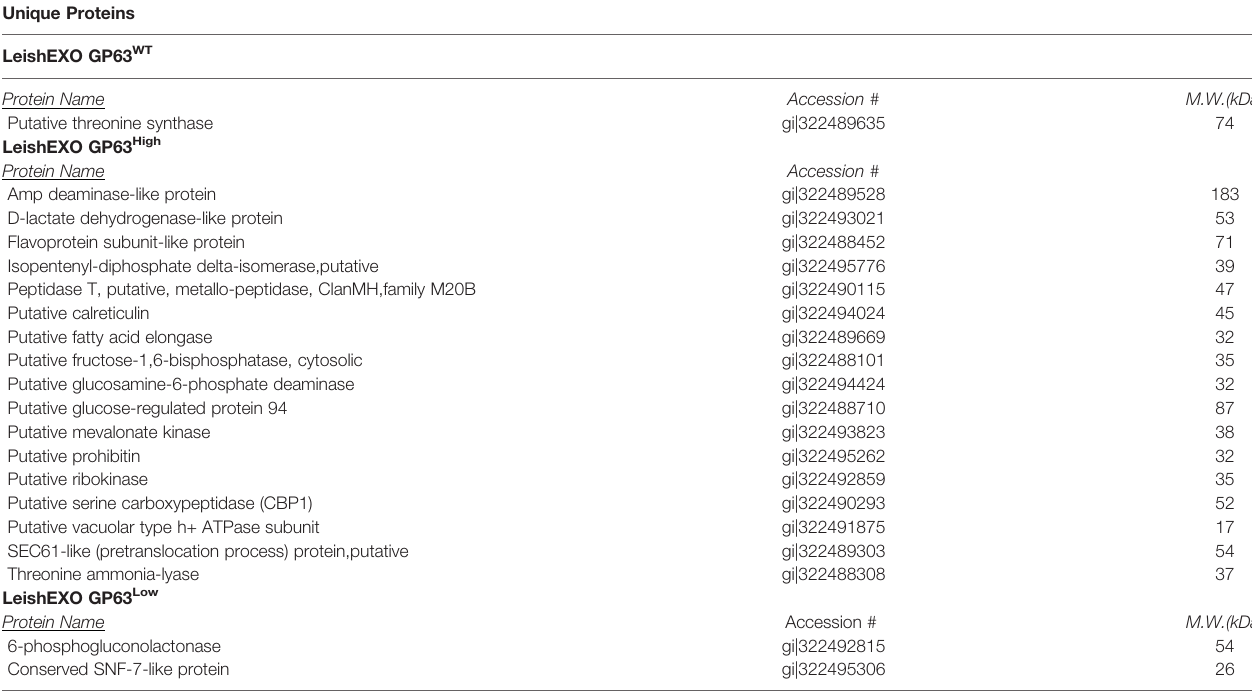
TABLE 1 | Unique proteins of Leishmania amazonensis GP63 WT , GP63 High, and GP63 Low -derived EVs detected by Mass Spectrometry. Unique Proteins